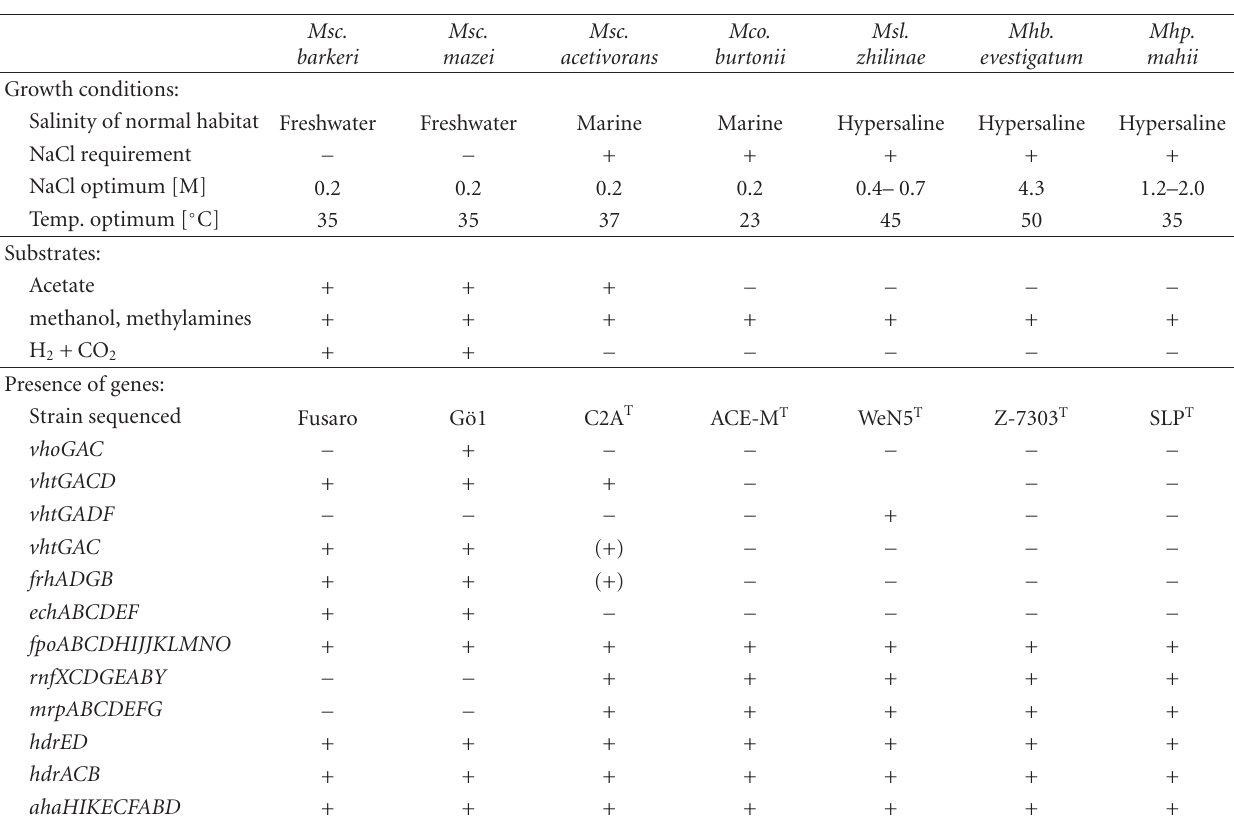
Table 3: The distribution of genes involved in the energy metabolism of members of the Methanosarcinaceae shows a correlation with the occupied habitat. The designation of genes is based on the proposed scheme of Rohlin and Gunsalus [42]. Phenotypic characteristics of the listed species were taken from Bergey’s Manual of Systematic Bacteriology [43]. Abbreviations: Msc, Methanosarcina; Mco ,